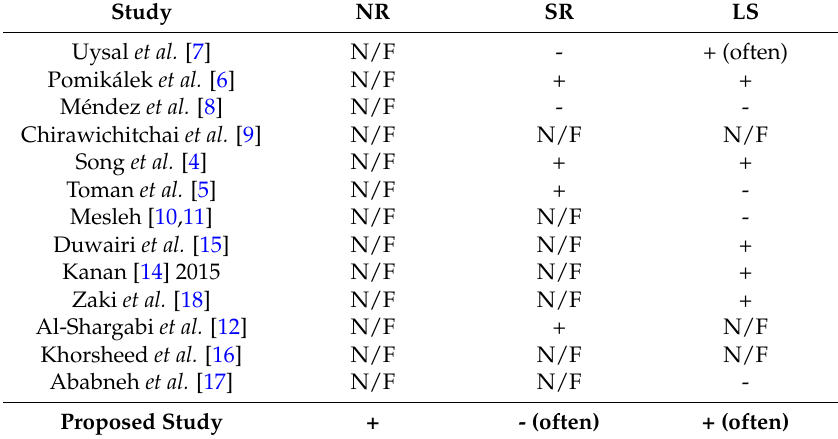
Table 9. The comparison of the influence of the preprocessing task in various studies and proposed study. Study